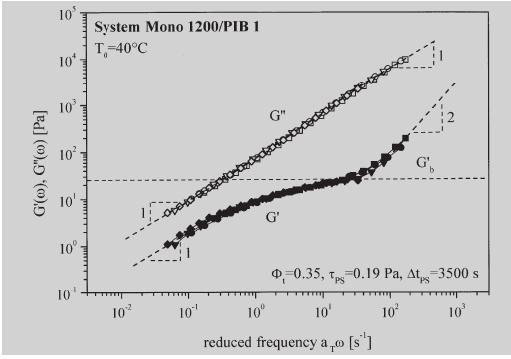
Figure 5: Time-temperature superposition of G´ and G´´ for the model suspension (system Mono 1200/PIB 1; F t = 0.35), T0 =